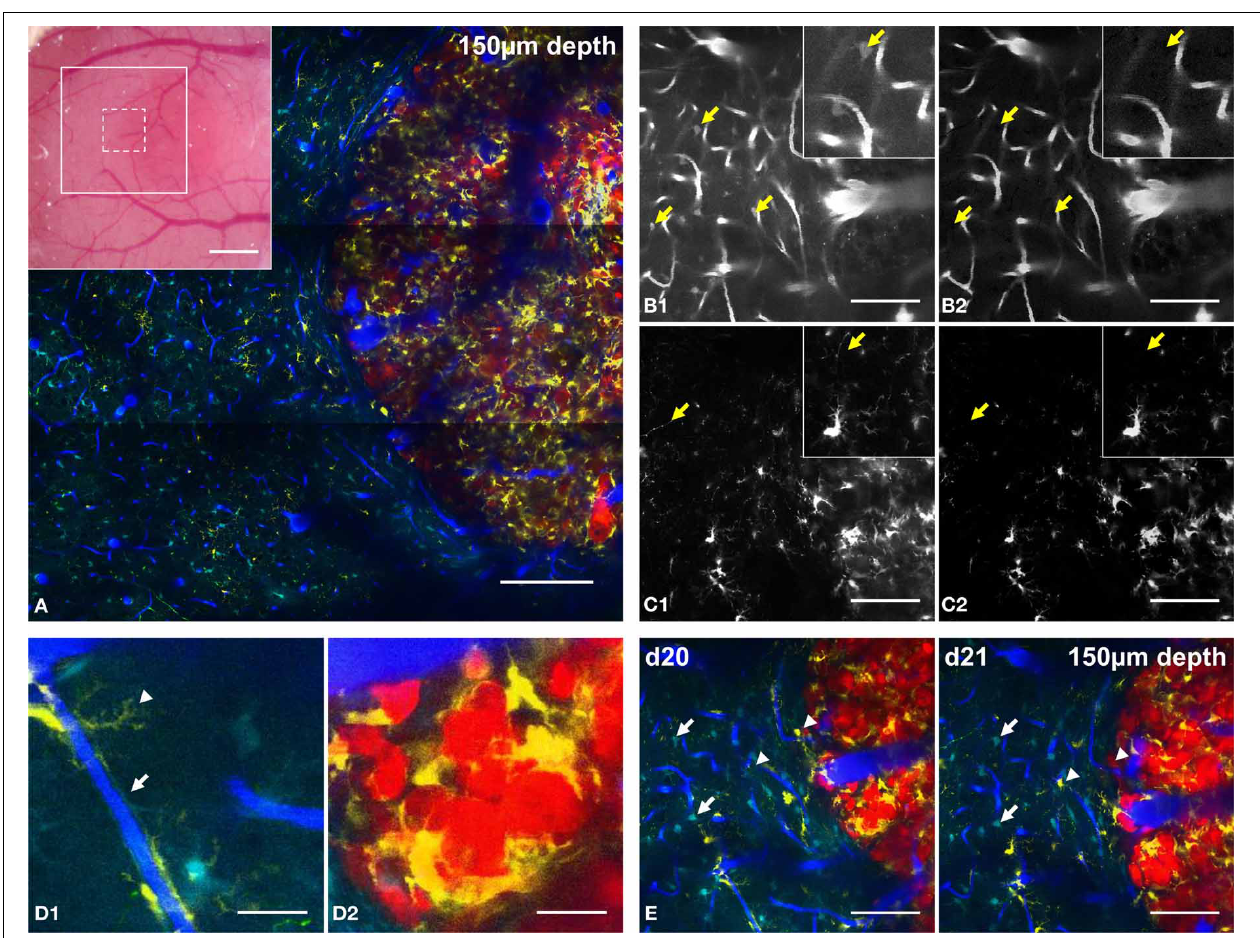
FIGURE 3 | Five-color intravital two-photon imaging of glioblastoma tumor and its dynamic environment. (A) 5-colors tile scan (3 × 3 images) of the GBM and its microenvironment; inset: macroscopic image of the cranial window with the area covered by the tile scan (large white square) and the area covered by a single plane acquisition (small dotted square). (B) Image of vasculature taken from NDD2-800 before (B1) and after (B2) spectral deconvolution; arrows: location of identified astrocytes that are removed from the image after spectal deconvolution; inset: zoom (100 × 100 μ m). (C) Image of CD11c-positive cells taken from NDD4-940 before (C1) and after (C2) spectral deconvolution; arrows: location of identified neurons that are removed after spectal deconvolution; inset: zoom (100 × 100 μ m). Note that the background